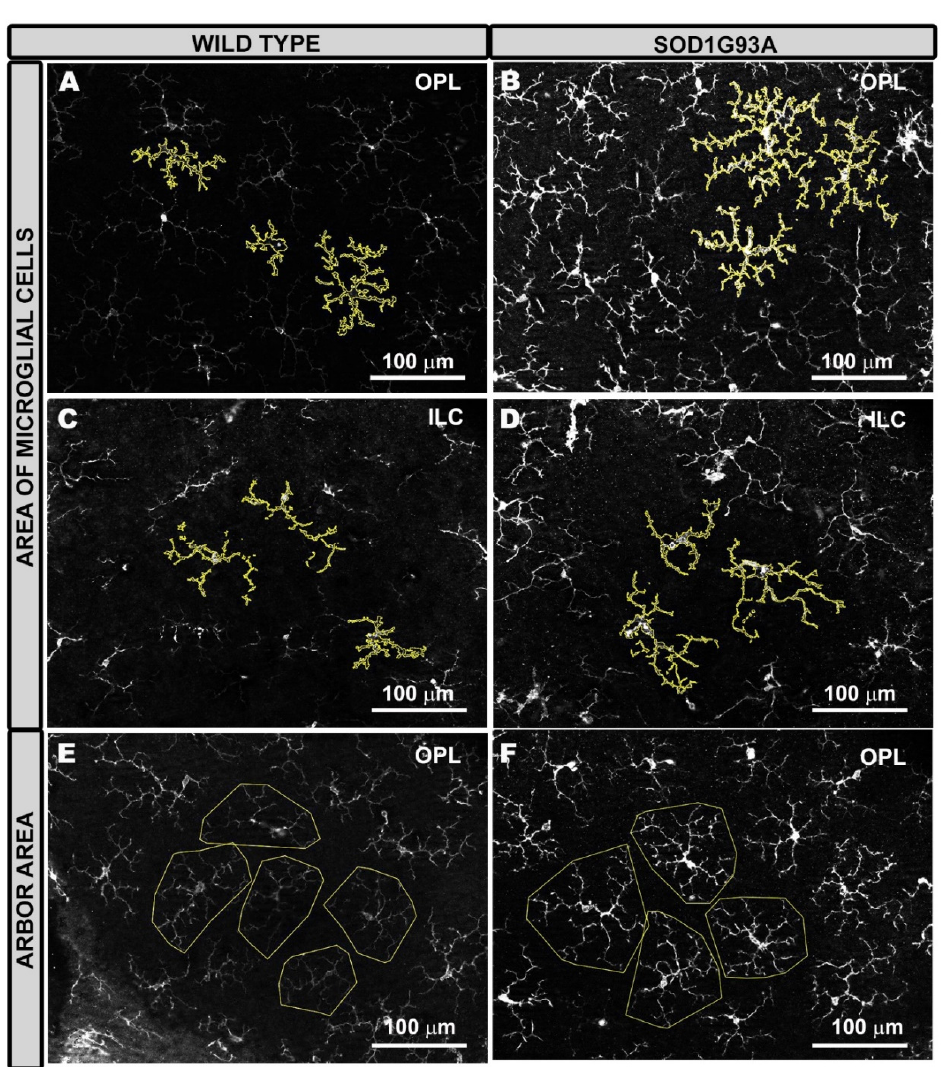
Figure 6. Representative images of the area of the microglial cells ( A –D) and the arbor area ( E , F ) in the wild type ( A , C , E ) and SOD1G93A ( B , D , F ) groups. The area of microglial cells was significantly larger in the SOD1G93A group ( B , D ) than in the wild type ( A , C ) in both OPL ( A , B ) and ILC ( C , D ), because both the soma and the processes were thicker. The arbor area was larger in the SOD1G93A group ( F ) than in the wild type group ( E ), but the difference was only significant in the inferior sector of the OPL. The increase in the arbor area is demonstrated by the larger size of the polygons due to the longer processes. Outer plexiform layer (OPL), and inner layer complex (ILC) (constituted by an inner plexiform layer and a nerve fiber–ganglion cell layer). Number of retinas used in the experiment, WT: n = 6; and SOD1G93A: n =